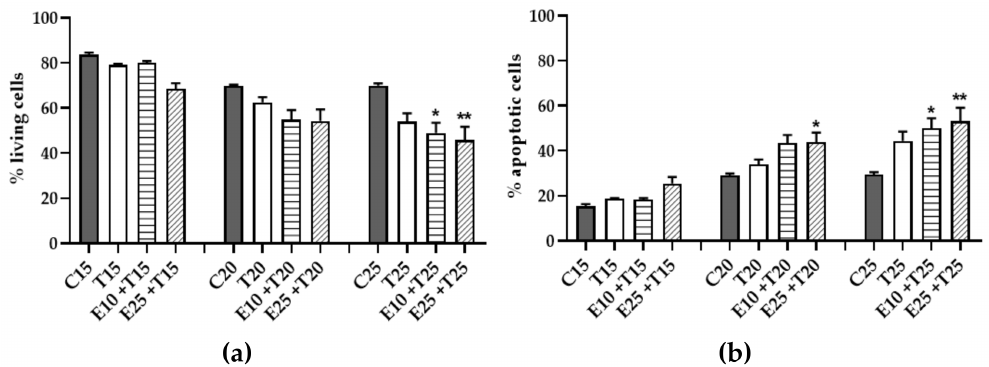
Figure 8. Cytotoxicity of UV-A rays and e ff ects of Rhus coriaria pre-treatment, flow cytometry evaluation. Cellular population was grouped in ( a ) living cells and ( b ) apoptotic cells. HMEC-1 cells were treated for 1 h with 10 or 25 µ g / mL of mERC (E10, E25) and exposed to 15, 20, 25 J / cm 2 UV-A (T15, T 20, T25). Results are expressed as mean ± SEM, n = 3. Statistical analysis: One-Way ANOVA with Bonferroni’s post hoc analysis. * p < 0.05, ** p < 0.01 vs. C